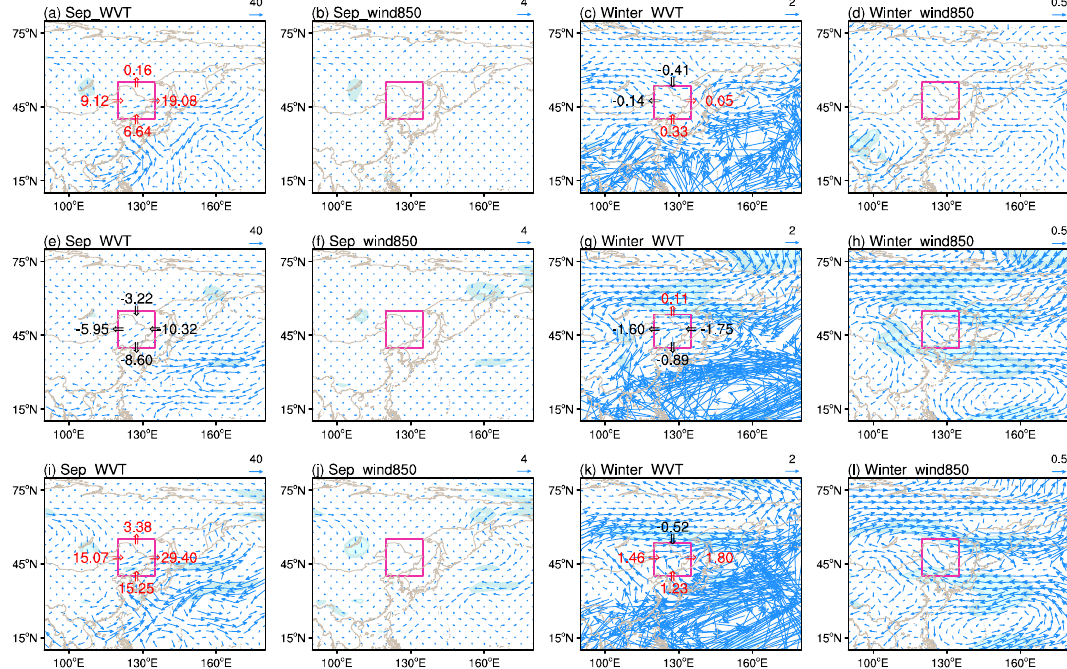
Figure 6. Composite di ff erences in September and wintertime vertically integrated water vapor transport (WVT; units: kg m − 1 s − 1 ) and 850 hPa winds (units: m s − 1 ) in the composite of more HSE years and more LSE years: the anomalies of vertically integrated WVT and 850-hPa winds in the composite of more HSE years in ( a , b ) September and ( c , d ) winter period; ( e – h ) as in ( a – d ) but for the composite of more LSE years; ( i – l ) as in ( a – d ) but for the di ff erence between more HSE years and more LSE years. Blue shading denotes where anomalies are significant at the 90% confidence level. Panels ( a , c , e , g , i , k ) show the anomaly values of water vapor transported over NEC.